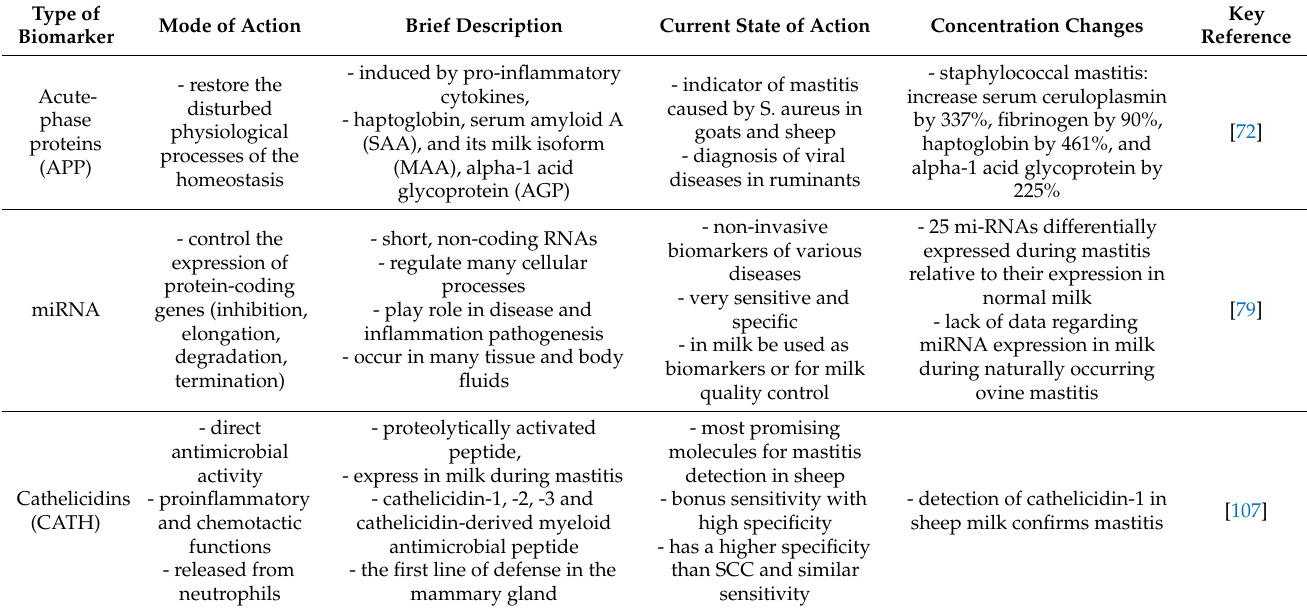
Table 2. Brief characteristics of new potential biomarkers for mastitis diagnosis in